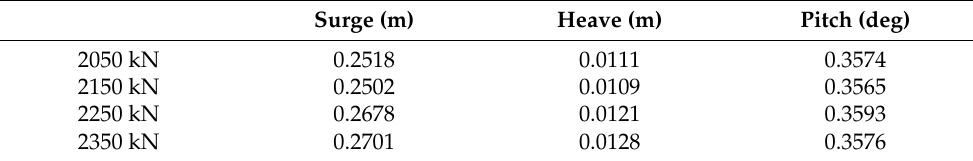
Table 12. Response RMS of different rope pretensions under normal operating conditions.